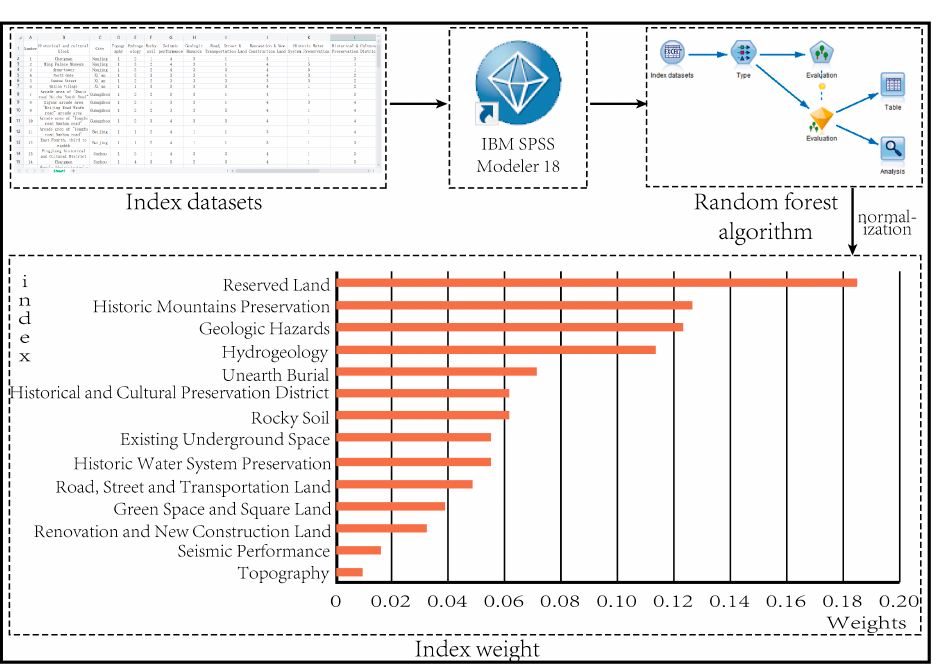
Figure 7. Process of suitability evaluation of USR.